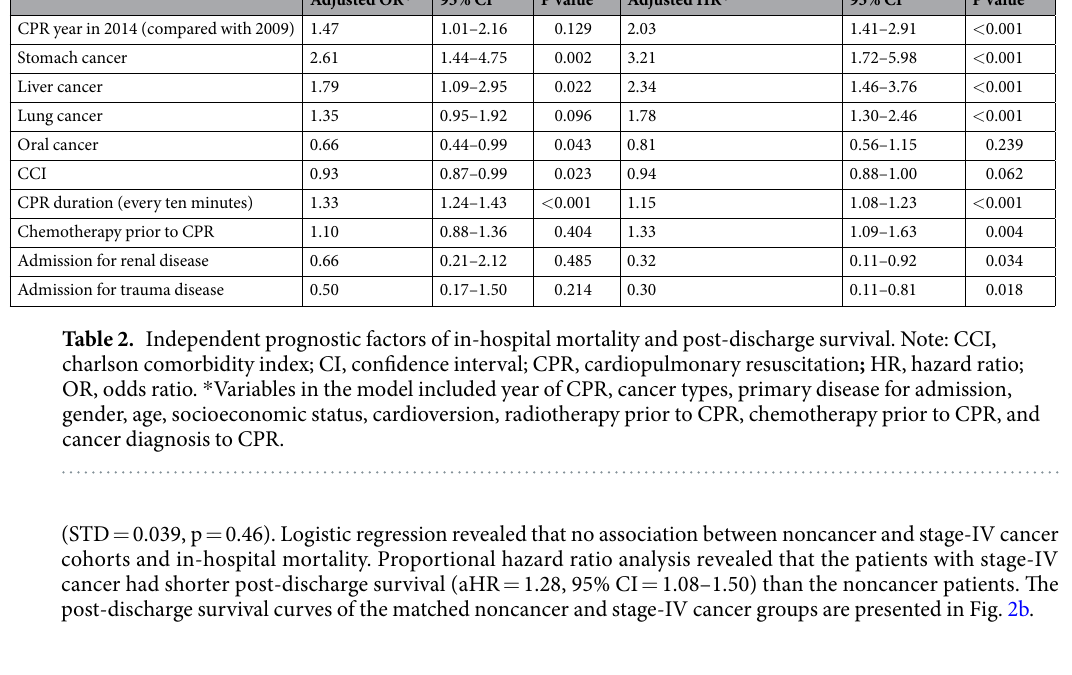
In-hospital mortality (logistic regression) Post-discharge survival (proportional hazards regression) Adjusted OR * 95% CI P value Adjusted HR * 95% CI P value CPR year in 2014 (compared with 2009) 1.47